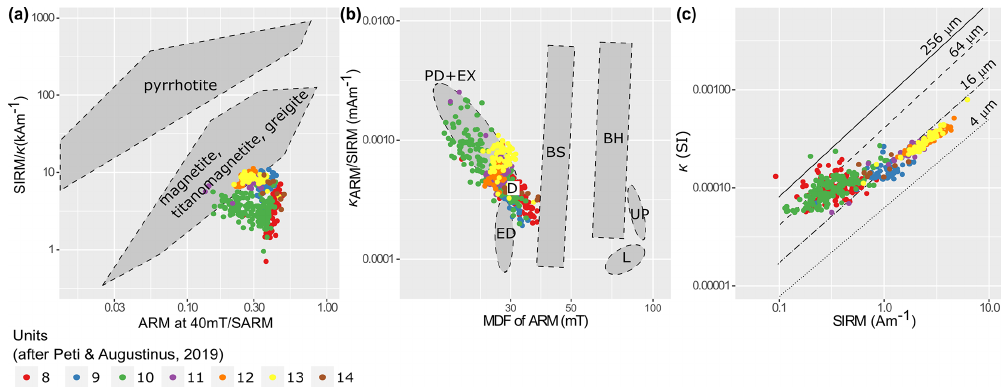
Figure 5. Rock magnetic characterisation of the Orakei sediment samples. (a) Qualitative identification of magnetic minerals following Peters and Thompson (1998). SARM: saturated ARM at 0mT. We note that the ARM at 40mT / SARM ratios are likely higher than the equivalent measurements of Peters and Thompson (1998) due to the lower maximum AF (80mT) used to induce the ARM. (b) Magnetic components of Orakei samples in comparison to components defined by Egli (2004). MDF: mean destructive field. κ ARM : susceptibility of ARM (SARM divided by applied bias field). BH: biogenic hard, high-coercivity magnetosomes. BS: biogenic soft, low-coercivity magne- tosomes. D: detrital particles transported in water systems. ED: aeolian dust/wind-blown particles. EX: ultrafine extracellular magnetite. L: maghemite component in loess. PD: pedogenic magnetite. UP: atmospheric particulate matter produced by urban pollution. (c) Estimated magnetic grain size indicator following Thompson and Oldfield (1986, p. 31). SIRM: saturated isothermal remanent magnetisation at